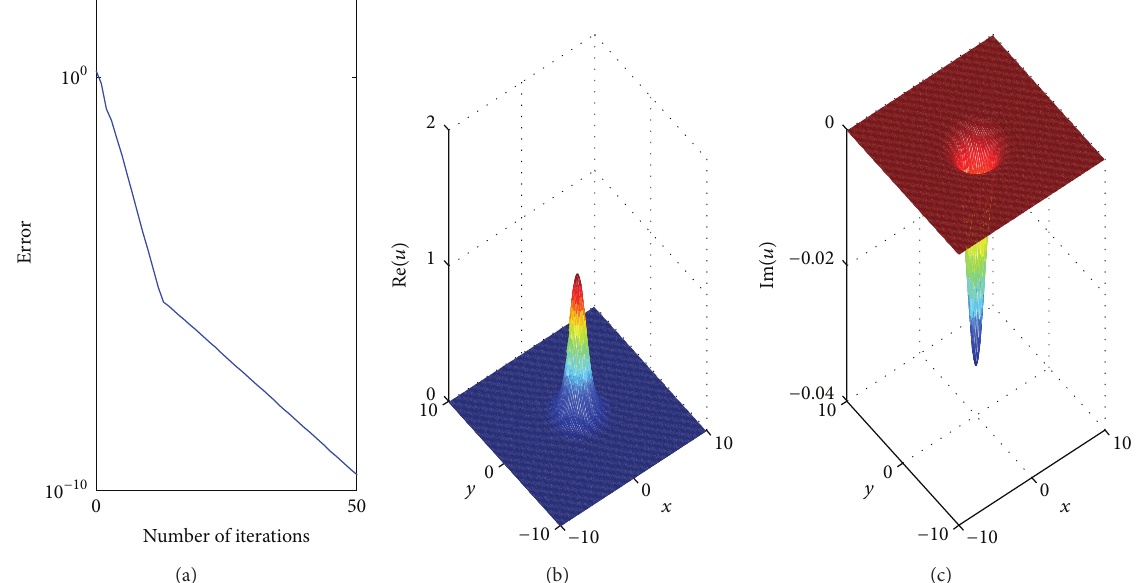
Figure 4: Convergence analysis for lattice soliton corresponding to the first renormalization factor with 𝜇 = 1.71 .